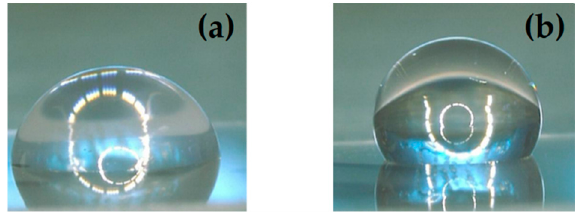
Figure 2. A 3 µL DI water droplet lying on the same Parylene-C coated surface before ( a ); and after ( b ) plasma treatment.